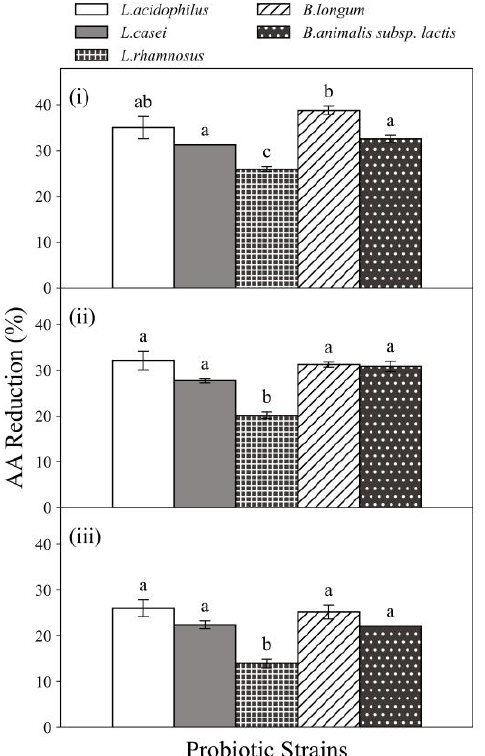
Figure 2. The acrylamide (AA) reduction ability of five strains of probiotic bacteria when exposed to ( i ) 350 ng/mL, ( ii ) 750 ng/mL and ( iii ) 1250 ng/mL AA solutions. Probiotic concentration was 10 9 CFU/mL. Incubated at 37 °C for 4 h at pH 6.5 – 7.0. Expressed as AA reduction percentage. Different characters in same panel indicate significant differences, whereas same character indicates